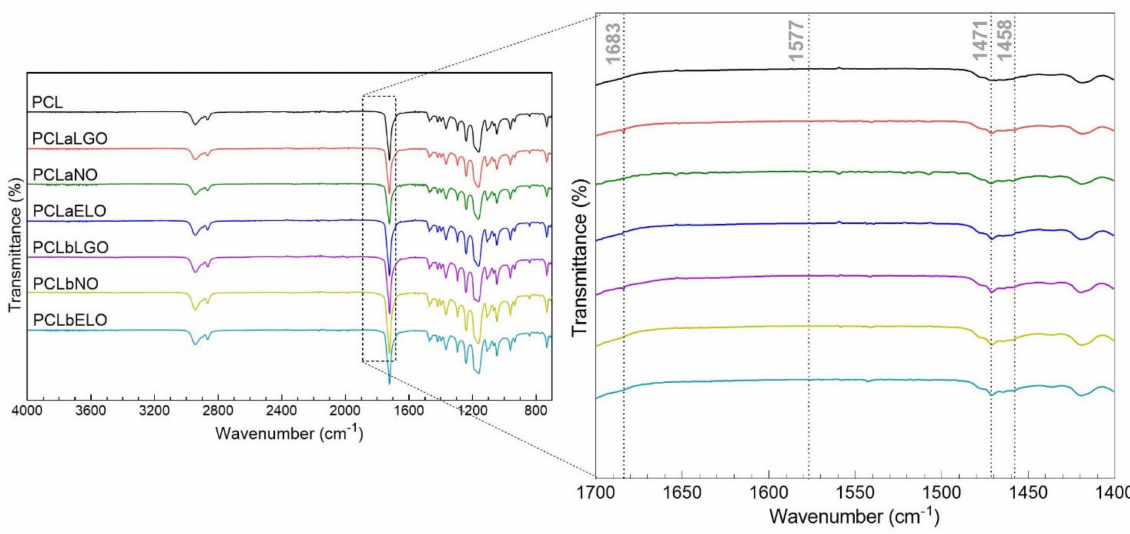
Figure 2. ATR-FTIR spectra of the PCL, PCLaEOs and PCLbEOs mats collected between 4000–700 cm − 1 . As the most significant for this study, the section between 1700–1400 cm − 1 was amplified.